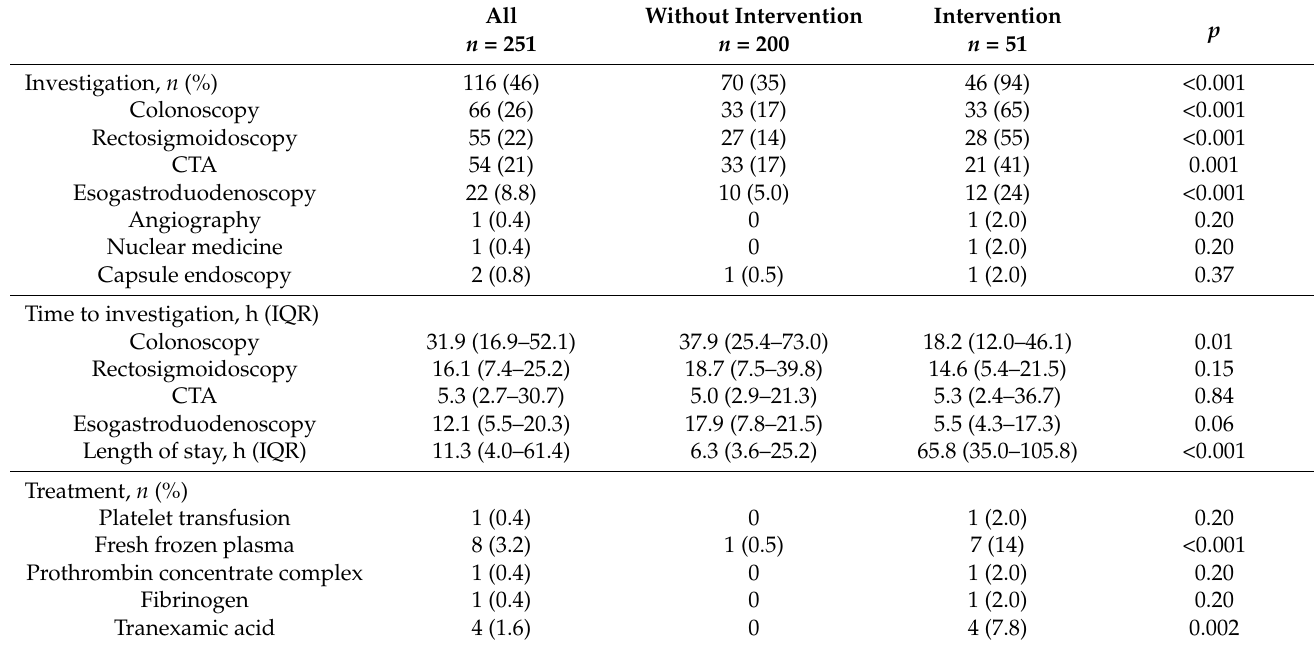
Table 3. Investigations and interventions not included in the SHA 2 PE